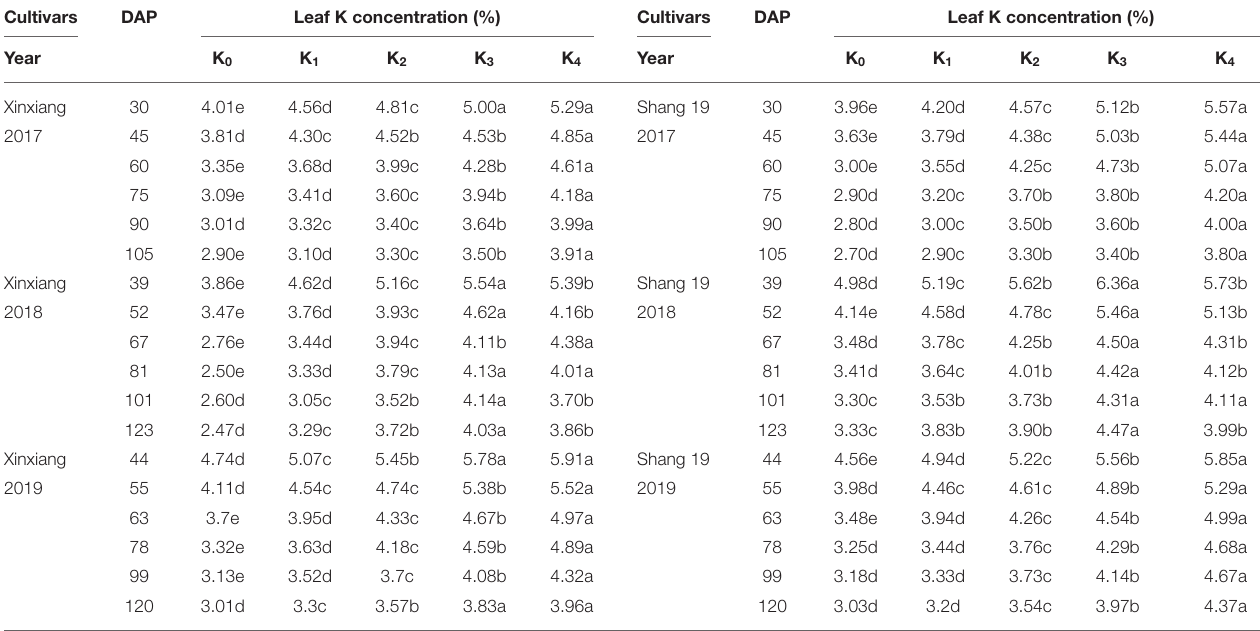
TABLE 3 | Leaf K concentration for sweet potato grown under different K application rates in three field experiments. Cultivars DAP Leaf K concentration (%) Cultivars DAP Leaf K concentration